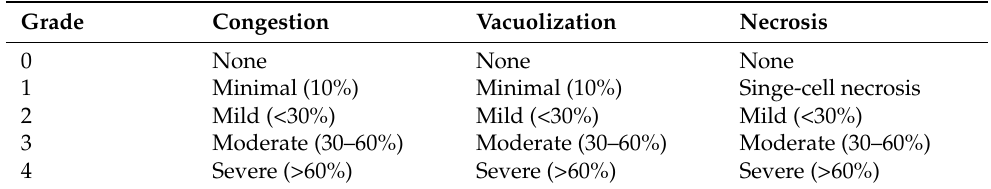
Table 3. The Suzuki histological